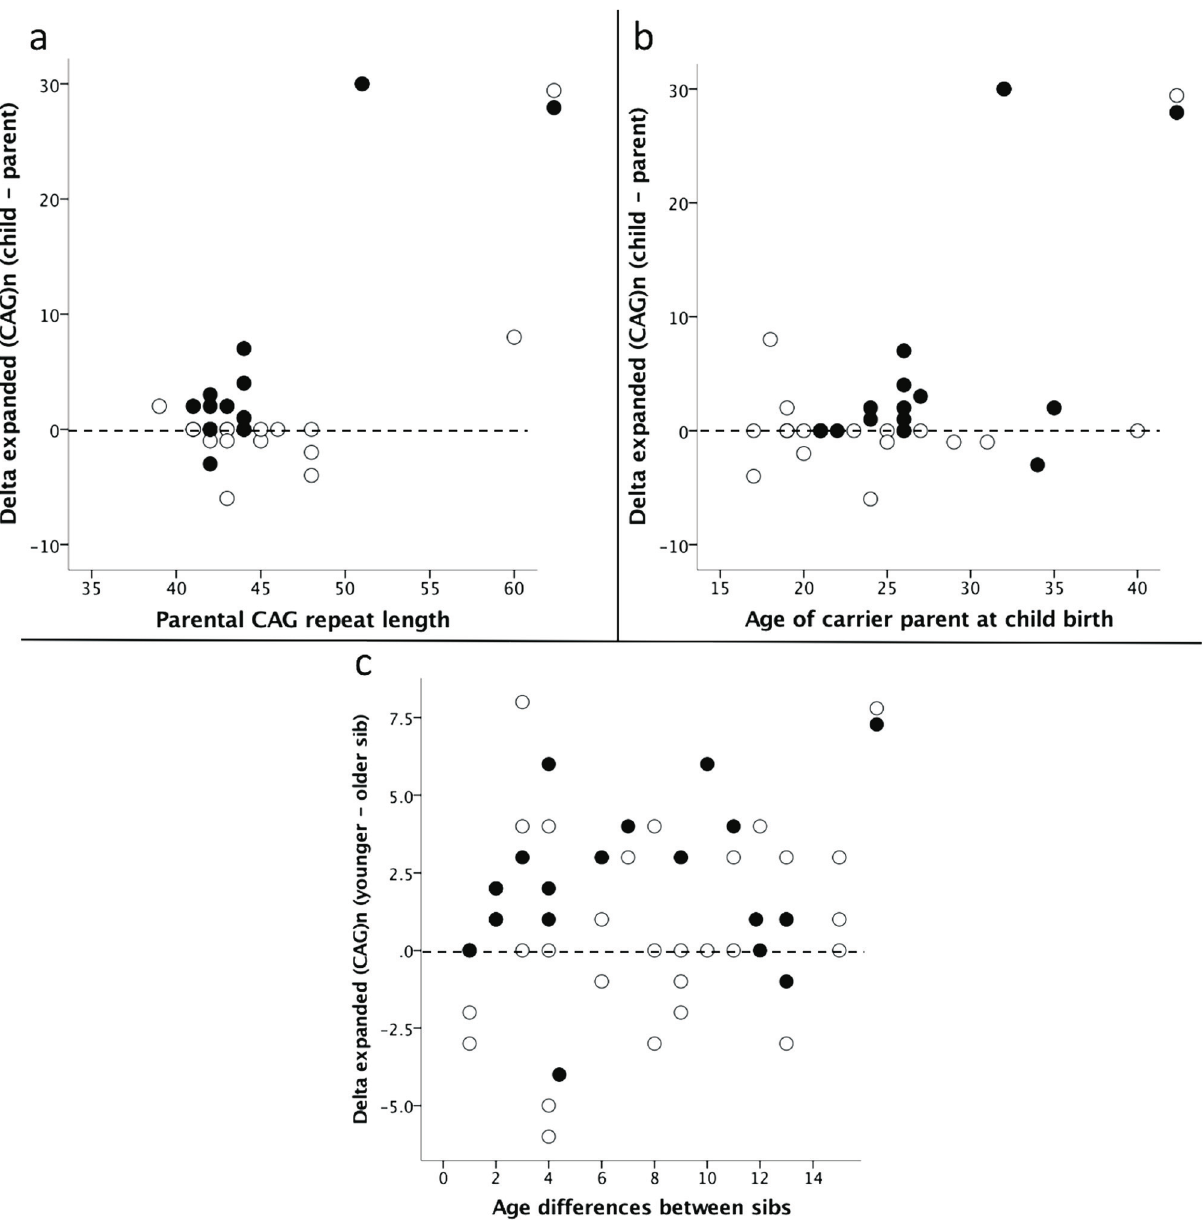
Figure 2 - Instability of expanded CAG repeats upon transmissions (dashed line corresponds to stability of the CAG repeat transmission). (a) Delta-expanded-(CAG)n child-parent according to parental CAG repeat length; (b) Delta-expanded-(CAG)n child-parent according to parental age at child-birth; (c) Delta-expanded-(CAG)n between siblings according to their age differences and gender of affected parent. Full circles: paternal transmis- sions; empty circles: maternal